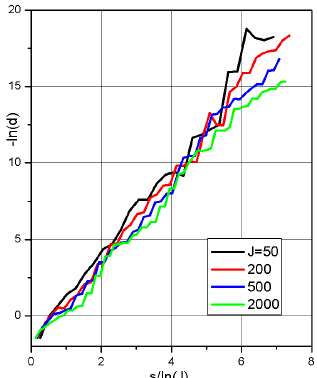
Figure 7. 5-solver, 9-scheme, Neumann.